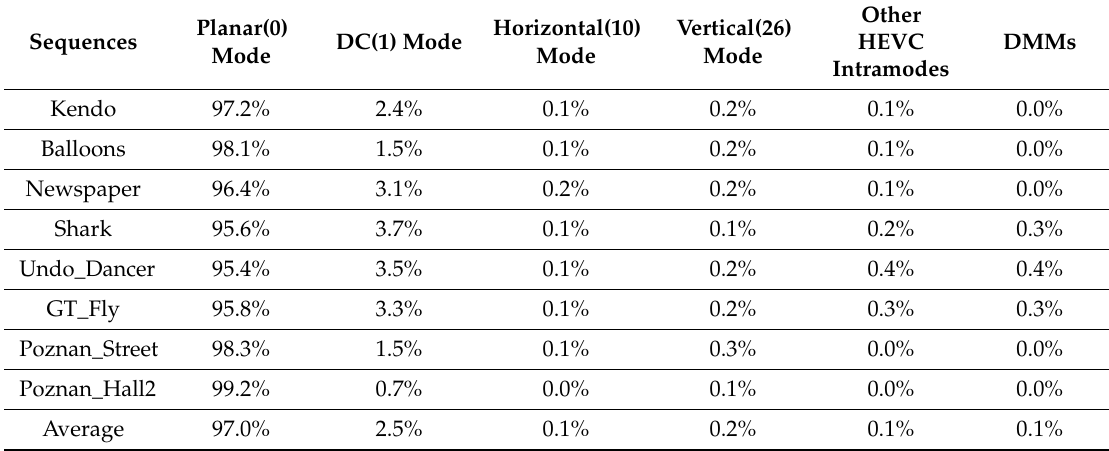
Table 4. Intramode distributions for simple region of treeblocks in depth map.